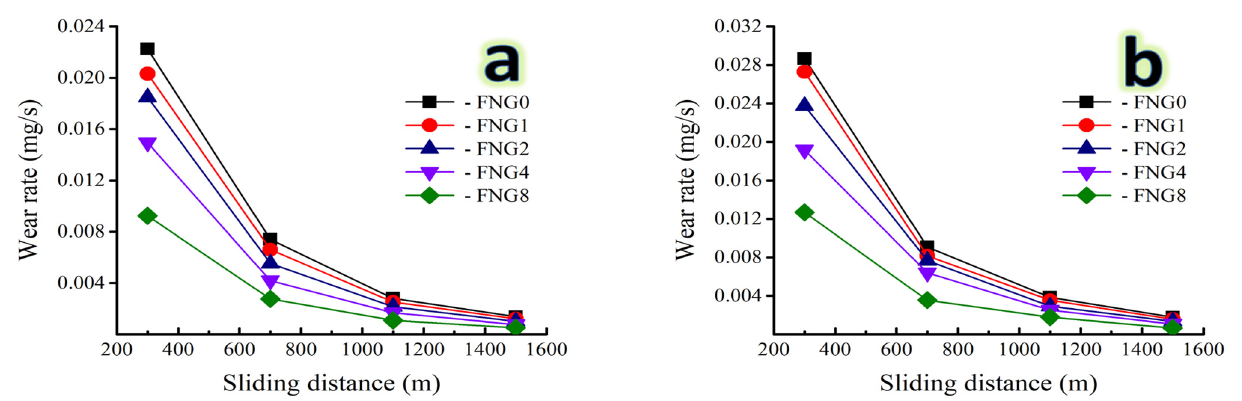
Figure 14. Wear rate of the Fe alloy and its nanocomposites as a function of the sliding distance at a load of ( a ) 10 N and ( b ) 30 N.